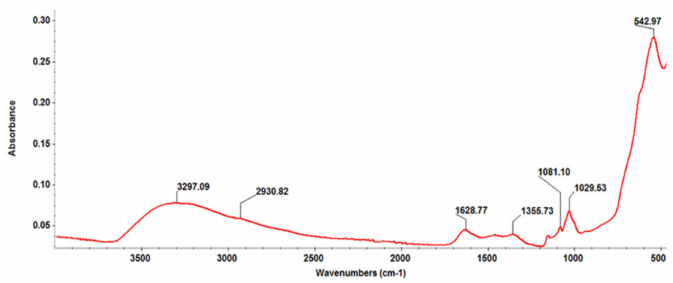
Figure 2. FT-IR spectrum of Fe 3 O 4 @ β -CD nanopowders.